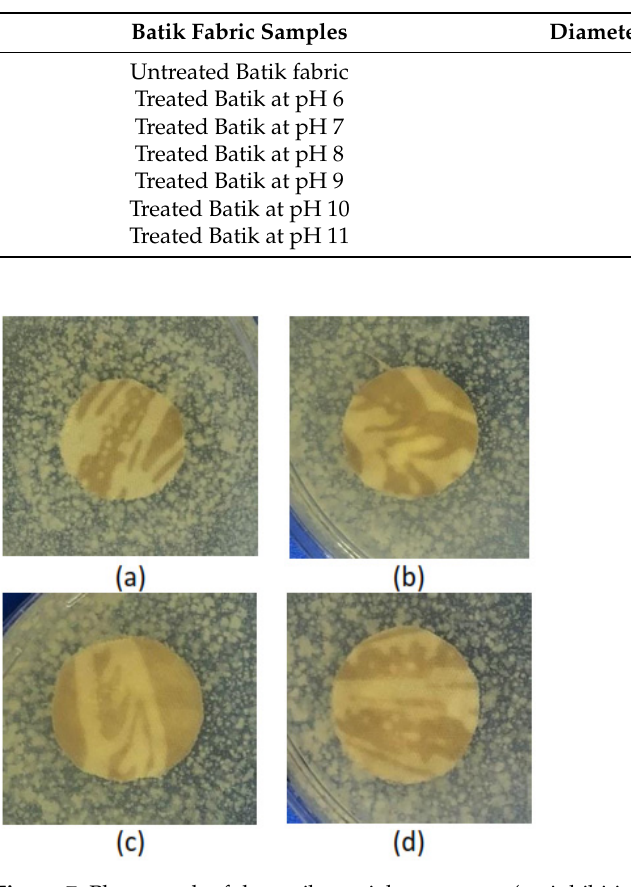
Figure 7. Photograph of the antibacterial assessment (no inhibition zone) of ( a ) treated Batik fabric at pH 6, ( b ) treated Batik fabric at pH 7, ( c ) treated Batik fabric at pH 8, ( d ) treated Batik fabric at pH 9.